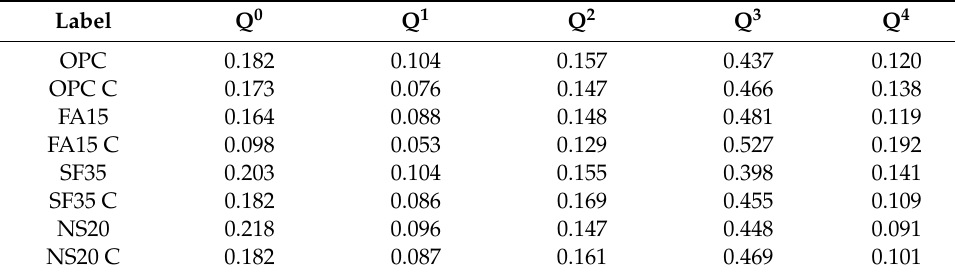
Table 4. Deconvoluted Intensities of Q n